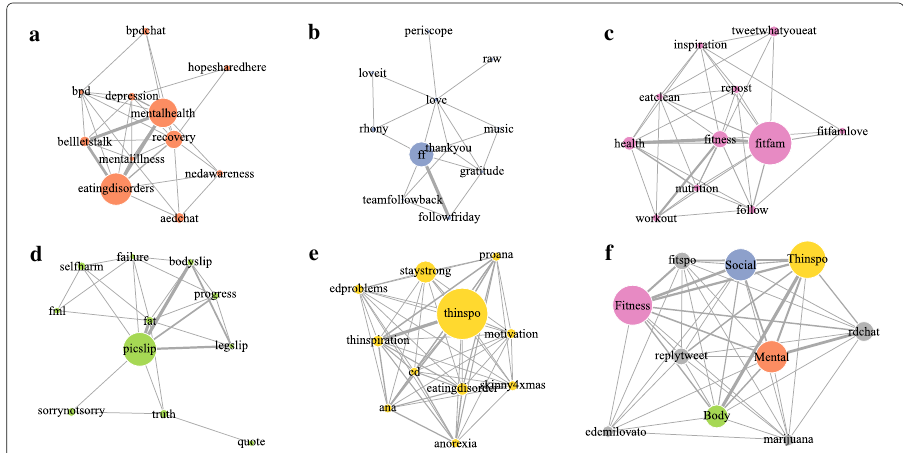
Fig. 1 Topics in hashtag co-occurrence networks. a - e Co-occurrence networks of the most frequent hashtags in each of the five popular topics, where each node denotes a hashtag. The size of a node is proportional to the number of tweets with a hashtag and edge width is proportional to the number of co-occurrences between tags. f Co-occurrences of popular topics involving more than 1000 users, where each node denotes a topic as labeled. The node size is proportional to the number of tweets mentioning a topic and edge width is proportional to the ratio of the number of tweets mentioning both topics over the number of tweets mentioning at least one